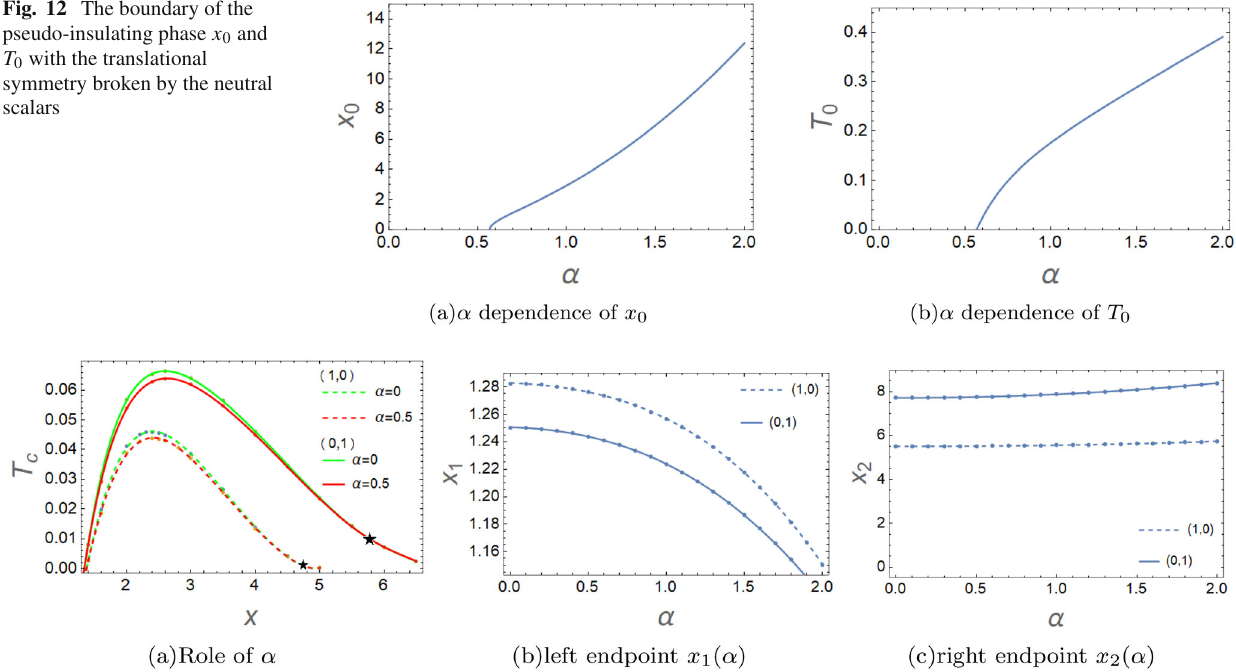
Fig. 13 The roles of α . a Changing α doesn’t make much difference, butinterchanging q A and q B makesabigdifference.Twocurvesfor α = 0 and α = 0 . 5 cross at (cid:18) . b , c The left endpoint x 1 and the right endpoint